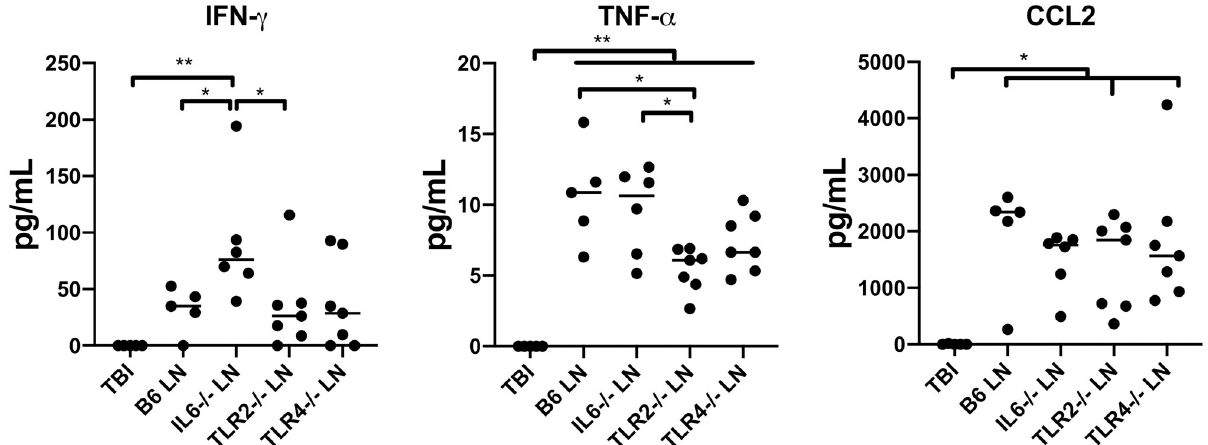
Fig 2. Inflammatory cytokines in BMF mice. IFN- γ , TNF- α , and CCL2 levels in the plasma of CByB6F1 BMF mice induced by infusion of LN cells from B6 (N = 5), IL-6 -/- (N = 6), TLR2 -/- (N = 7), and TLR4 -/- (N = 7) mice. CByB6F1 mice post TBI without LN infusion were controls (TBI, N = 5). � , P < .05; �� , P <